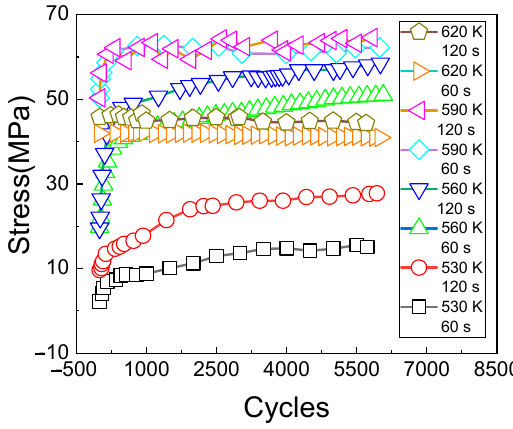
Figure 10. Stress changes with cycles.